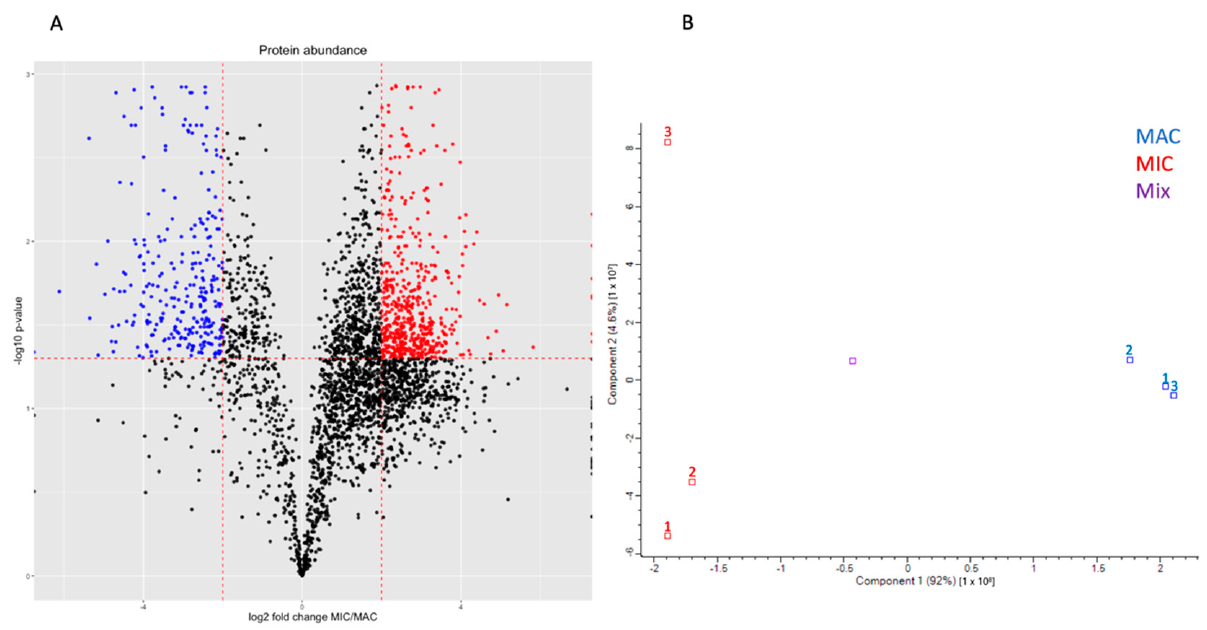
Figure 1. Proteomic analysis of TMT-labeled Oxytricha nuclear samples. ( A ) Volcano plot generated with ggplot2 [29] of identified protein groups from mass spectrometry data. Proteins predicted to localize to mitochondria using DeepLoc2 were removed. The log2 ratio of average MIC sample reporter ion intensity over average MIC sample reporter ion intensity was plotted against the inverse log10 of the FDR-adjusted p -value of the difference between nuclei. Proteins significantly enriched in either the MAC or MIC (log2 ratio < − 2 or > 2 and adjusted p -value < 0.05) were plotted in blue and red points respectively. ( B ) PCA analysis generated with Perseus [30] of the intensities from the 3 MAC and MIC replicates are plotted in blue and red, respectively, as well as the control mix of all 6 samples plotted in purple. The MAC and MIC samples are well separated along PC1, which accounts for most of the variability between nuclear samples. While the MIC replicates do not cluster together as tightly as the MAC replicates on PC2, this component represents far less of the variance among the samples compared to